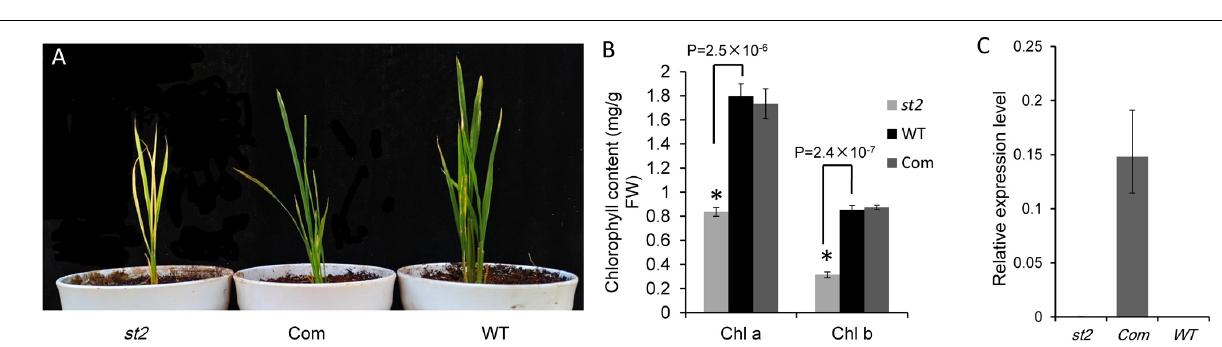
FIGURE 5 | (A) Phenotypic comparison of st2 , complemented T 0 (Com), and the WT of st2 . The st2 mutant and WT were grown 28 days in the green house, and the completed T 0 was 14 days after transplant. (B) The chlorophyll content of st2 , Com, and WT. The means and standard deviations were obtained from three independent leaf samples. Statistical analysis was performed with the t -test. ∗ P = 0.05. (C) The transcription levels of SiSTL2 in st2 , WT, and transgenic lines. The means and standard deviations are obtained from three independent leaf